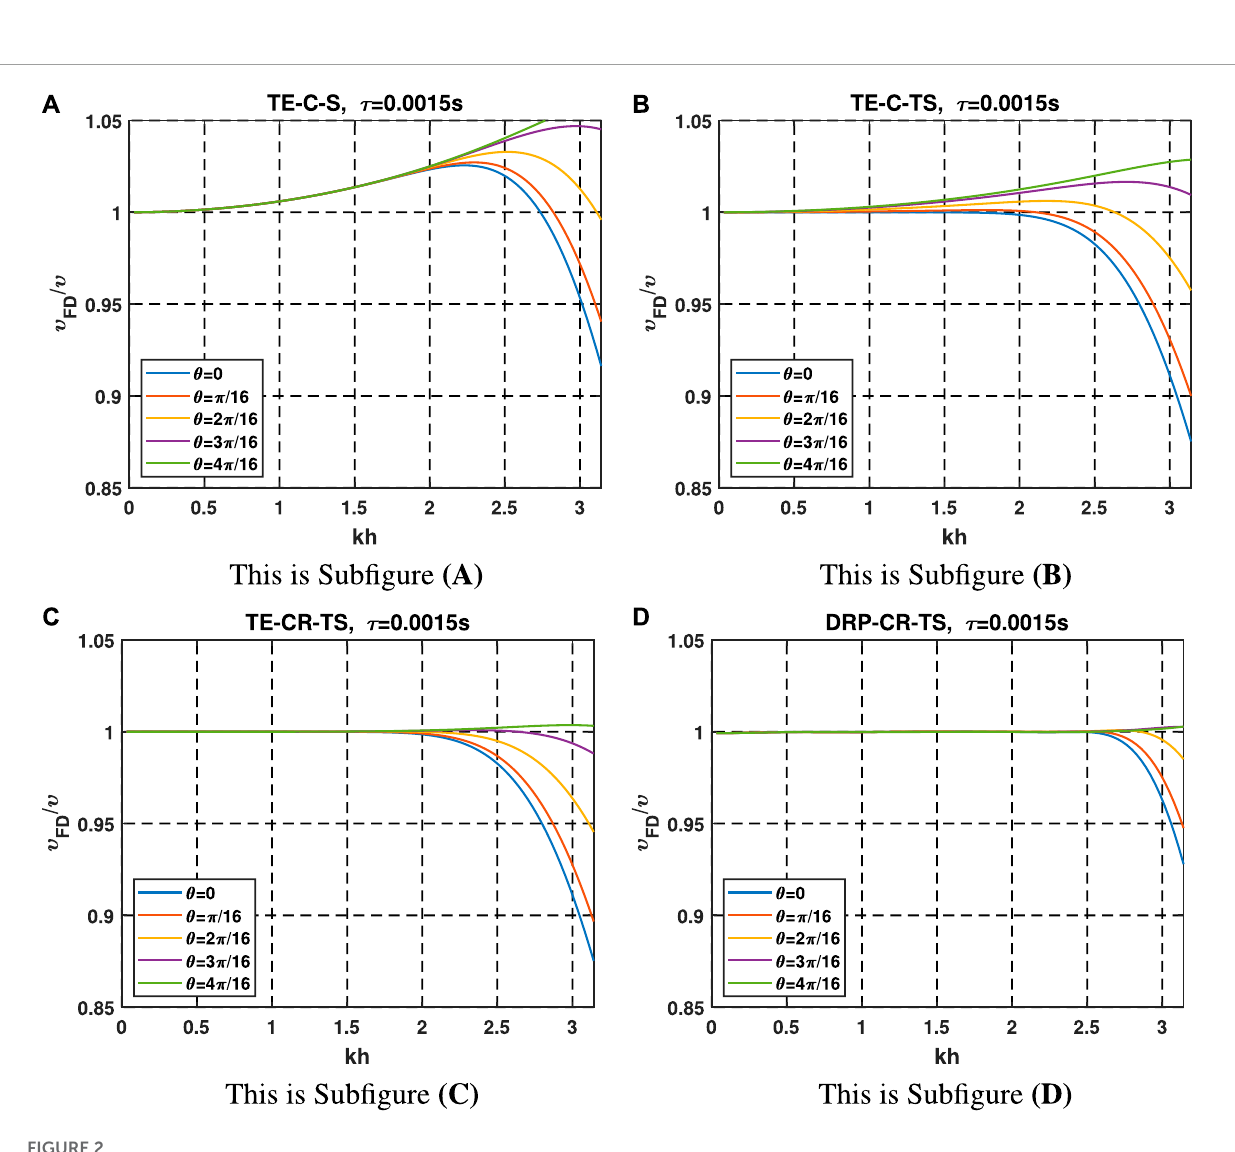
FIGURE 2 Dispersion curves of the four methods with a moderate time step τ = 0.0015 s (A) TE-C-S method. (B) TE-C-TS method. (C) TE-CR-TS method. (D) DRP-CR-TS